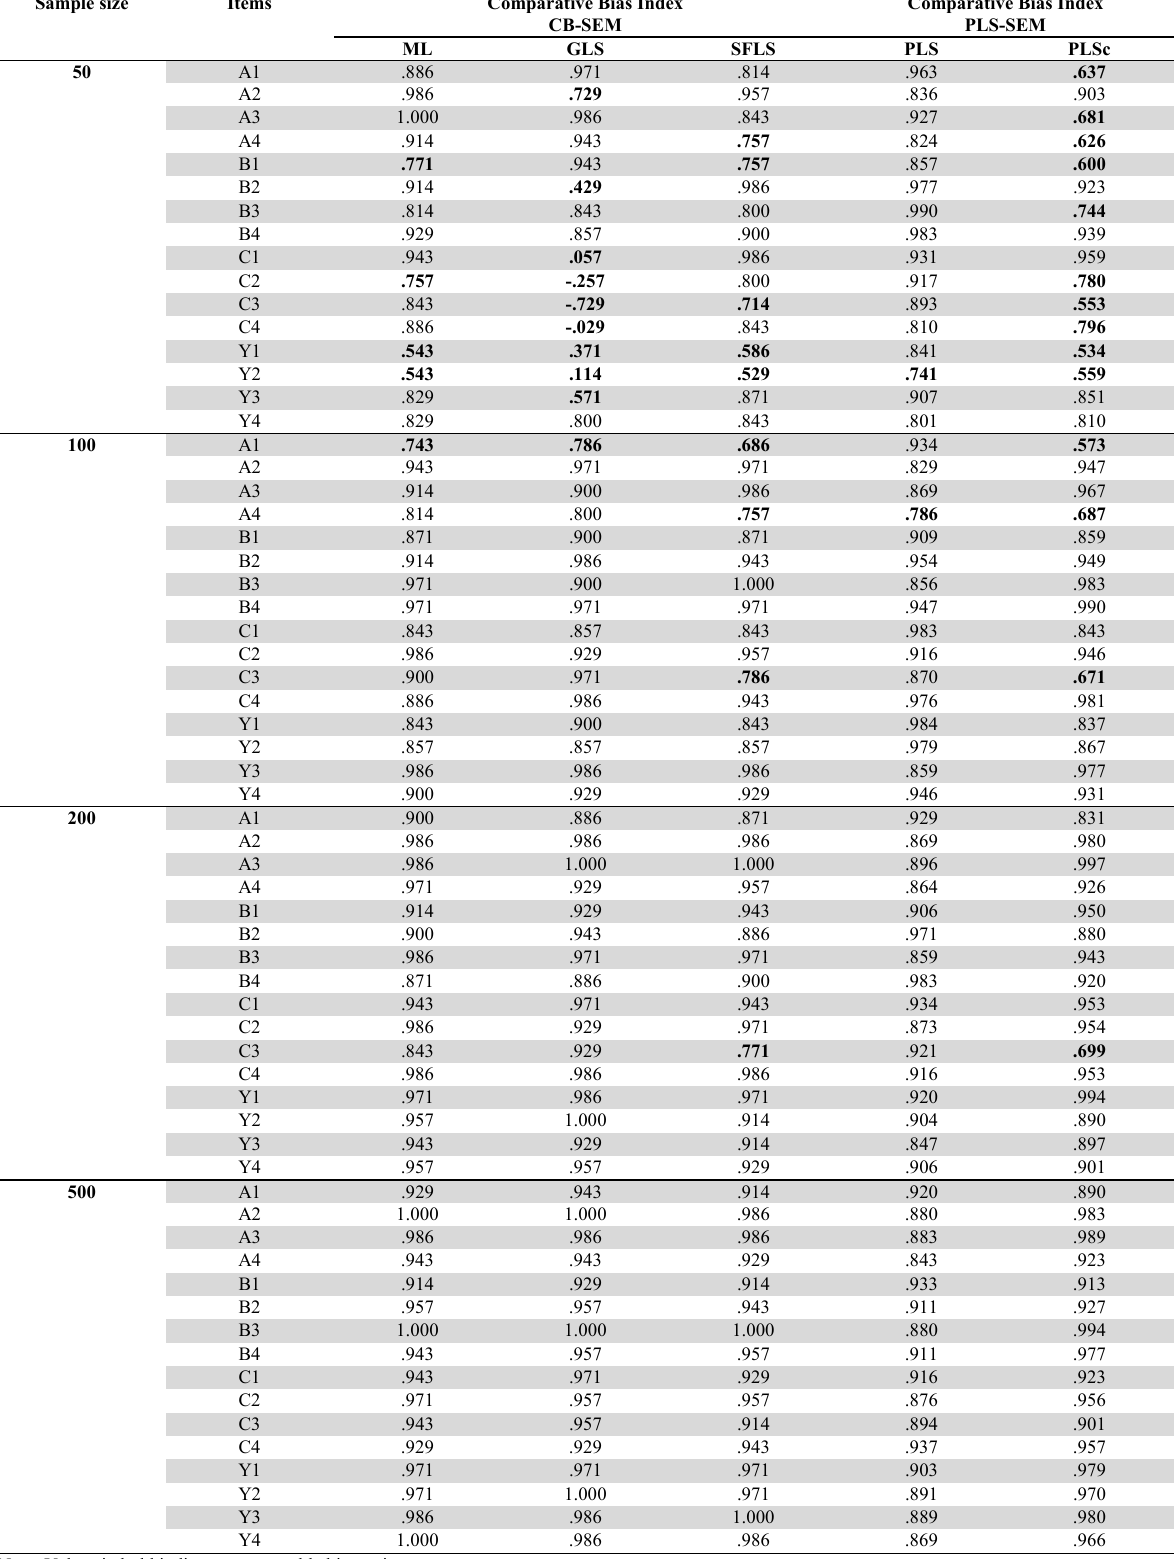
Table 1 The Comparative Bias Index (CBI) - Model 1 Sample